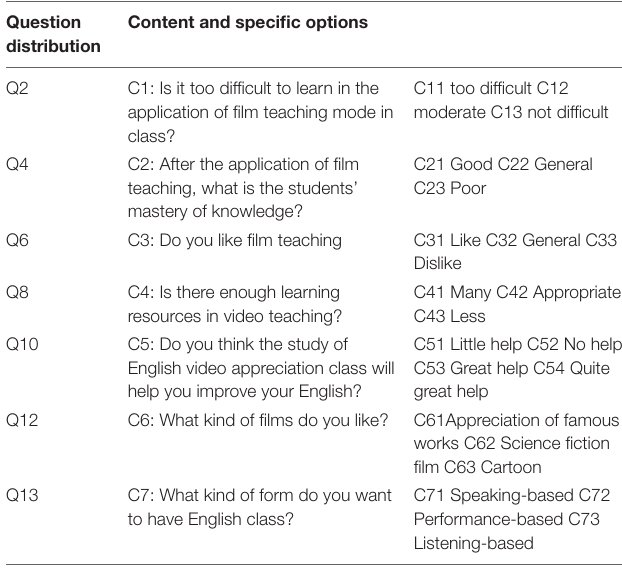
TABLE 1 | Key question setting of the questionnaire.